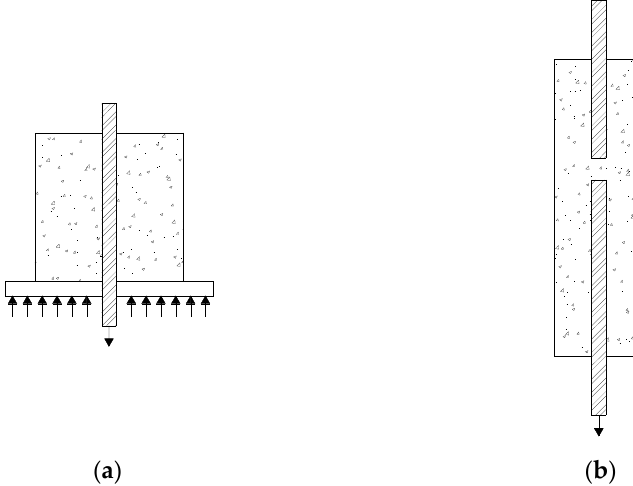
Figure 1. ( a ) Pull-out test with short embedment length; ( b ) modified version of Danish standard pull-out test.